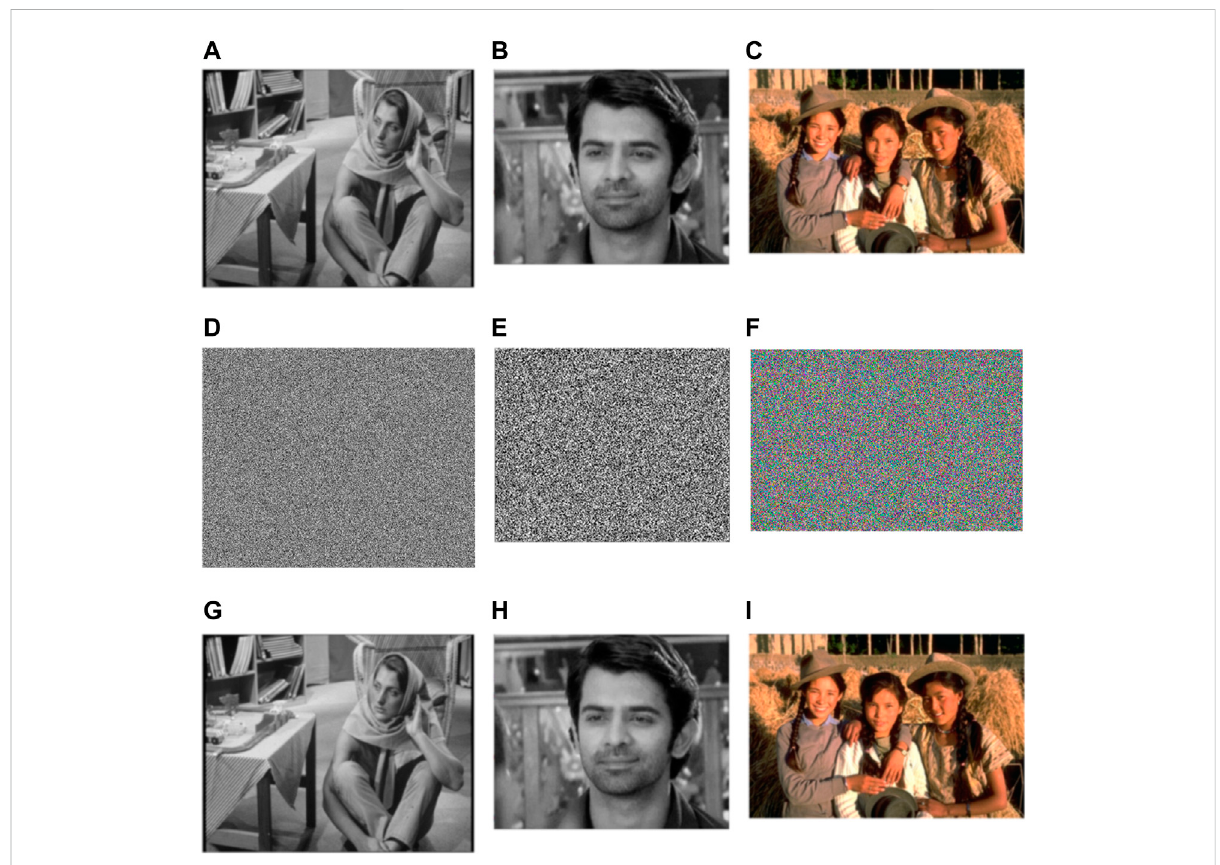
FIGURE 14 Plaintextimages,ciphertextimagesanddecryptionimages: (A) “ Barbara, ” (B) “ Arnav, ” (C) “ Girls, ” (D) “ Barbara, ” (E) “ Arnav, ” (F) “ Girls, ” (G) “ Barbara, ” (H) “ Arnav, ” (I) “ Girls. ” ( “ Barbara ” is from the University of Southern California ’ s signal and image process institute image dataset, “ Arnav ” is from the IMDB-WIKI 500k dataset, “ Girls ” is from the Berkeley segmentation dataset (BSD) 500